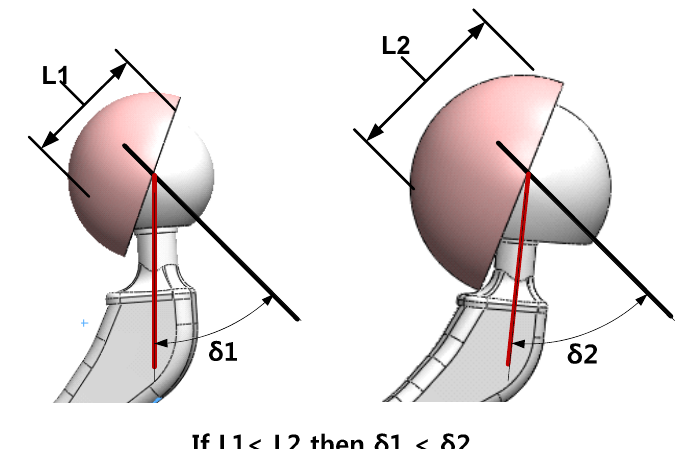
Fig. 8. Relation between different ball head diameters and ROM. ROM was greater with larger ball head than smaller ball